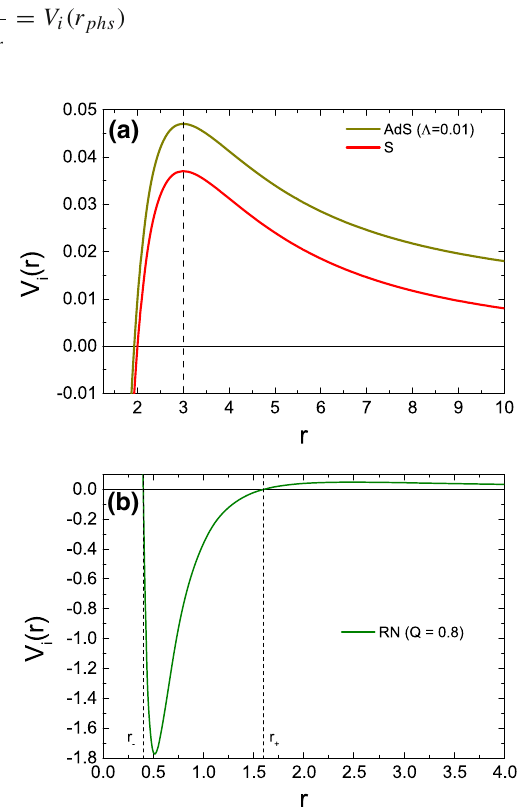
Fig. 1 An effective energy potential V i ( r ) (Eq. 11) for S, AdS ( a ) and RN ( b ) spacetimes ( M =